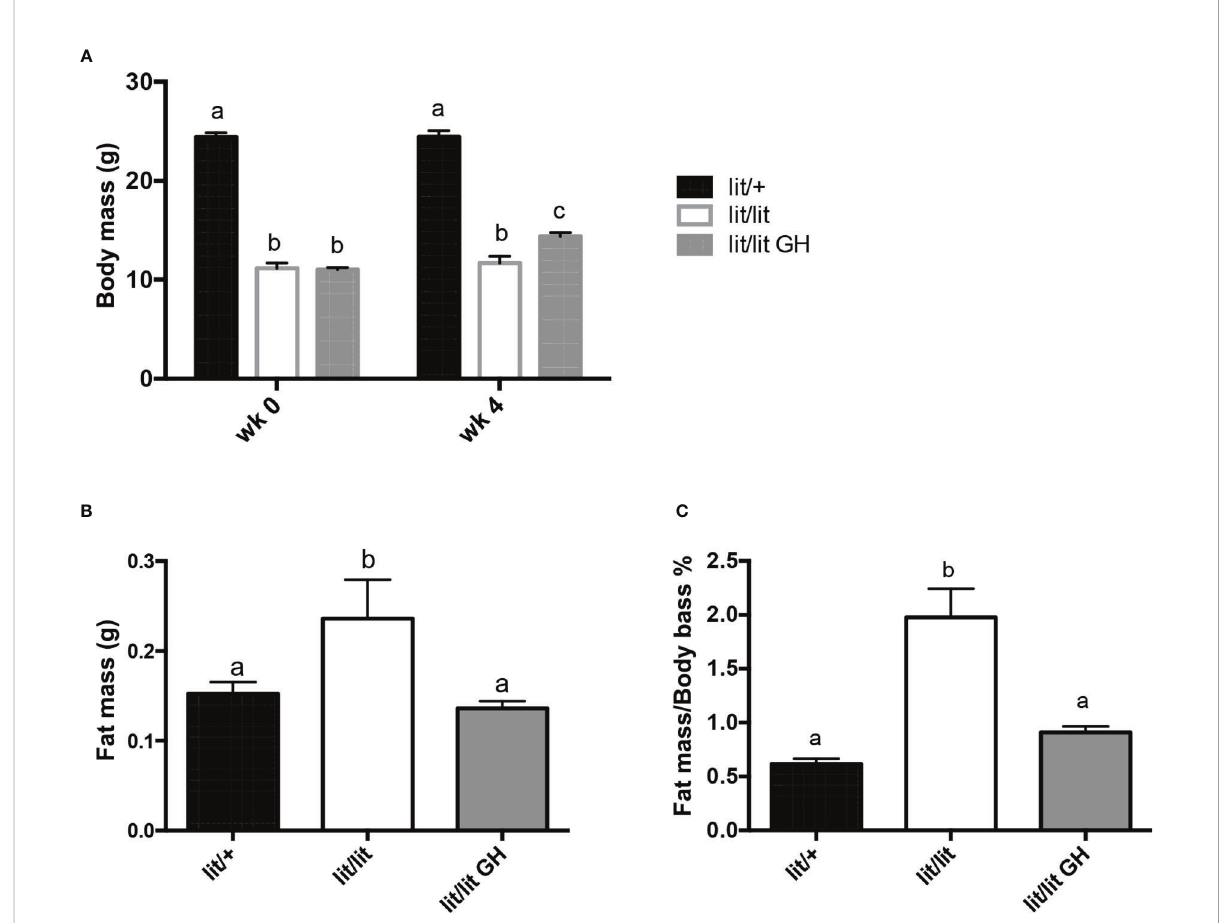
FIGURE 1 Effects of GH de fi ciency and GH injection on body mass and fat mass of mice. Three groups of 9-week-old male lit/lit, lit/lit, and lit/+ mice from the same litters were injected with 2 m g/g body mass of recombinant bovine GH, vehicle control, and vehicle control, respectively, once a day for 4 weeks. Body mass and mass of inguinal subcutaneous fat pads were recorded at the beginning (wk 0) and end (wk 4) of the experiment. (A) Body mass. (B) Mass of inguinal subcutaneous fat pads. (C) Inguinal fat pad mass as percentage of body mass. Data are expressed as mean ± SEM (n = 5 mice). Means labeled with different letters are statistically different ( P <